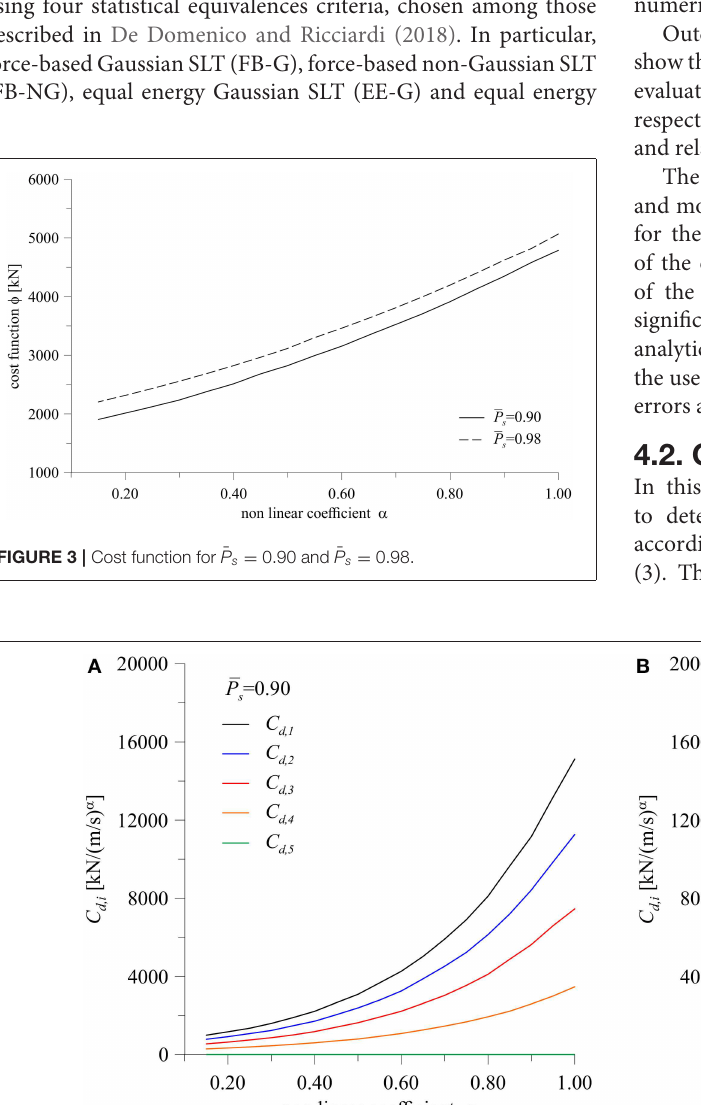
0.90 and (B) ¯ P s 0.98. = =